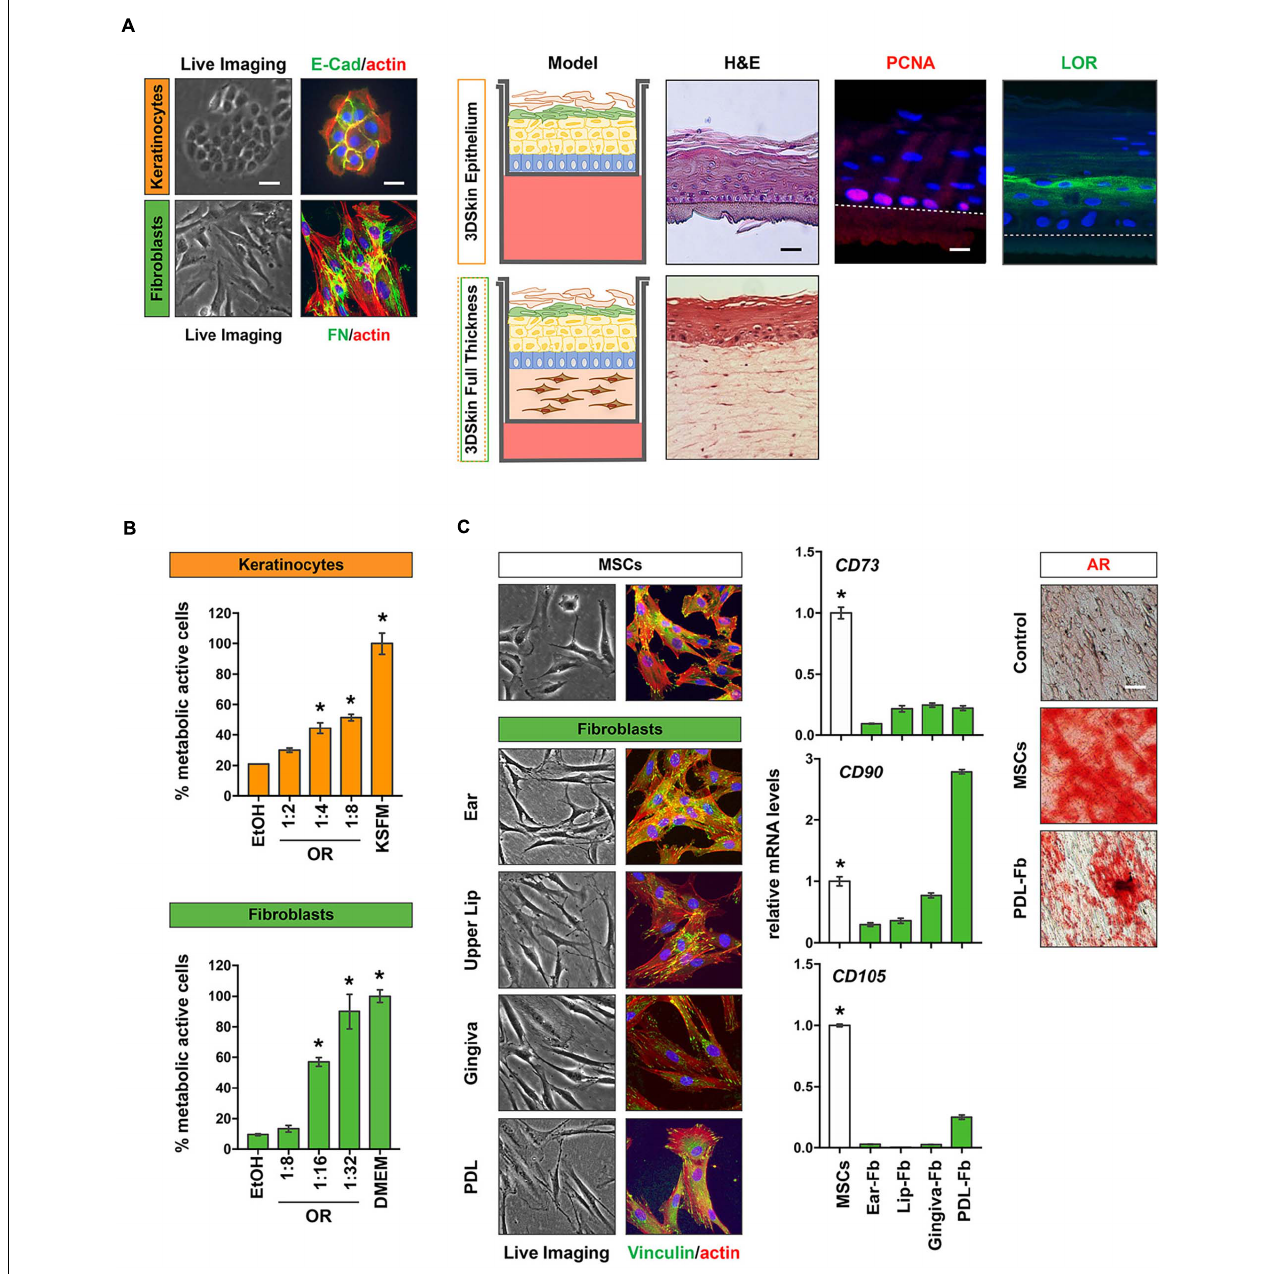
FIGURE 6 | Potential outlook for the use of patient-derived cells from the cranio-/orofacial region. (A) CLP patient-derived keratinocytes (orange) and fibroblasts (green) were isolated from CLP patients and characterized by staining for E-Cad (keratinocytes) and FN (fibroblasts). Scale bars: 50 µ m (Live Imaging), 25 µ m (IF). These cells were used to obtain 3D skin differentiation models (top) that can be stained for H&E, the proliferation marker PCNA (red) and Loricrin (LOR, green). Note that PCNA is only detectable in basal keratinocytes, whereas LOR is present in more superficial keratinocyte layers confirming the in vivo situation. Dotted line indicates the membrane. Scale bars: 50 µ m (Live Imaging), 25 µ m (IF). Alternatively, the isolation of both keratinocytes and fibroblasts from the same tissue donor allows the establishment of full-thickness 3D-skin models, in which CLP keratinocytes are plated on a dermis created by the corresponding fibroblasts that also can be stained (H&E, bottom). * p < 0.05 EtOH vs. oral rinse or KSFM or DMEM. (B) Healthy gingival keratinocytes (orange) and fibroblasts (green) were used to determine cytotoxicity of a commercially available oral rinse (OR) at different dilutions after a 2 min exposure by MTT assay. Metabolic active cells are plotted as percentage of the initial cell population. (C) Cranio-/orofacial derived fibroblasts share similar characteristics with MSCs and may have a potential in personalized regenerative therapeutic approaches. Like MSCs, fibroblasts have a spindle-like morphology and are plastic-adherent, as revealed by live imaging and vinculin staining (green). Furthermore, qPCR analyses revealed that our patient-derived fibroblasts also express the typical MSC markers CD73 , CD90 , and CD105 . * p < 0.05 MSC vs. Fbs. Alizarin Red S (AR) staining indicates the potential of PDL fibroblasts to be differentiated into bone forming cells. Scale bar: 20 µ m. Data are expressed as mean ± SD. n =